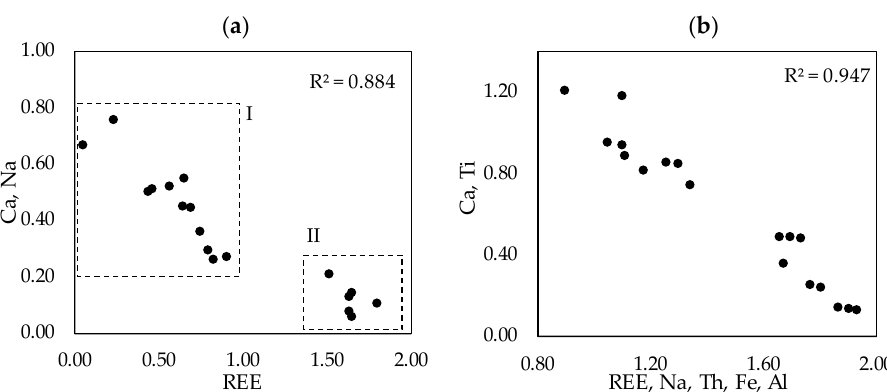
Figure 12. Solid solution character of LREE ferrotitanate series, depicted as ionic proportions of the ( a ) substitutions of Ca and Na with REE on A site and ( b ) complete transformation, where (REE + Na + Th) + (Fe + Al) = Ca + Ti. Region annotated with I on (a) refers to the area of real solid solution, region annotated with II on ( a ) indicates to the measurements on transitional phases. Adapted after Campbell et al. and Nickel & McAdam [77,84]. The equation is changed for a best description of present situation (i.e., Nb is left out of the equation whilst Th and Al are added to A and B sites, respectively). Figures are based on data from Tables 5 and 6.